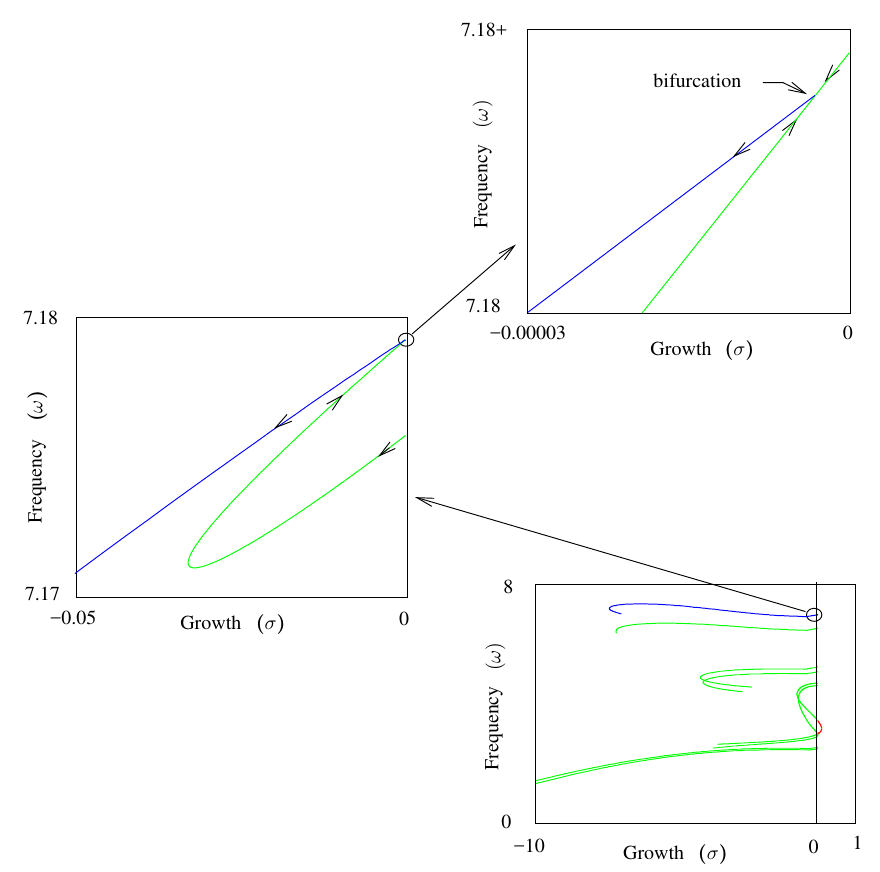
Figure 14. Bifurcation in a V - σ - ω process. Arrows indicate the direction of positive µ , the blue curve arises from the bifurcation (Green means stable, red means